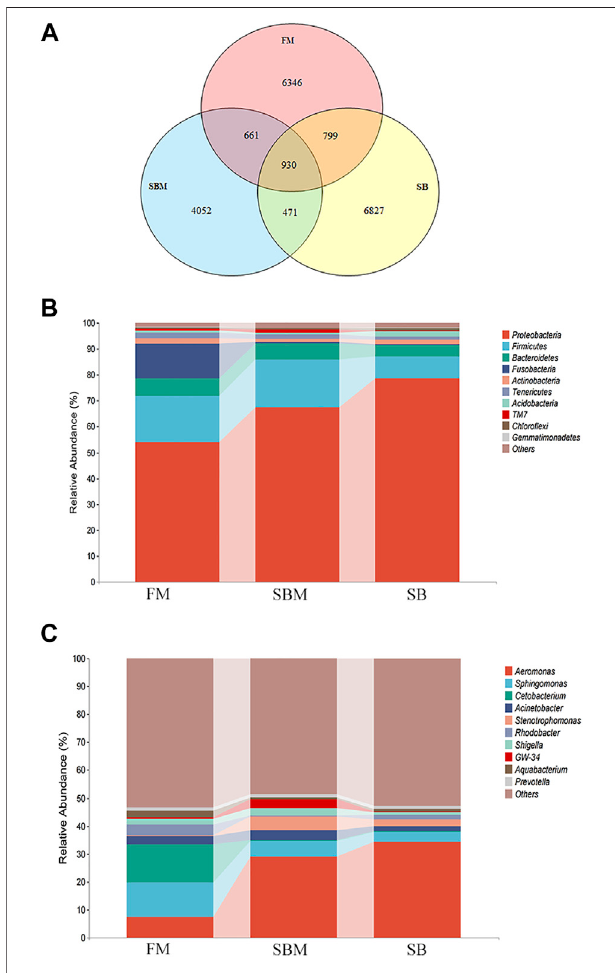
FIGURE 5 | Analysis of intestinal microbiota OTU and composition in fl uenced by seabuckthorn dietary inclusion in zebra fi sh SBMIE adult model. (A) Venn diagram of OTU in FM, SBM and SB groups; (B) hindgut bacteria composition at phylum level; (C) hindgut bacteria composition at the genus level. The alteration trends between adjacent bars for the current revealed taxa were indicated by the interval